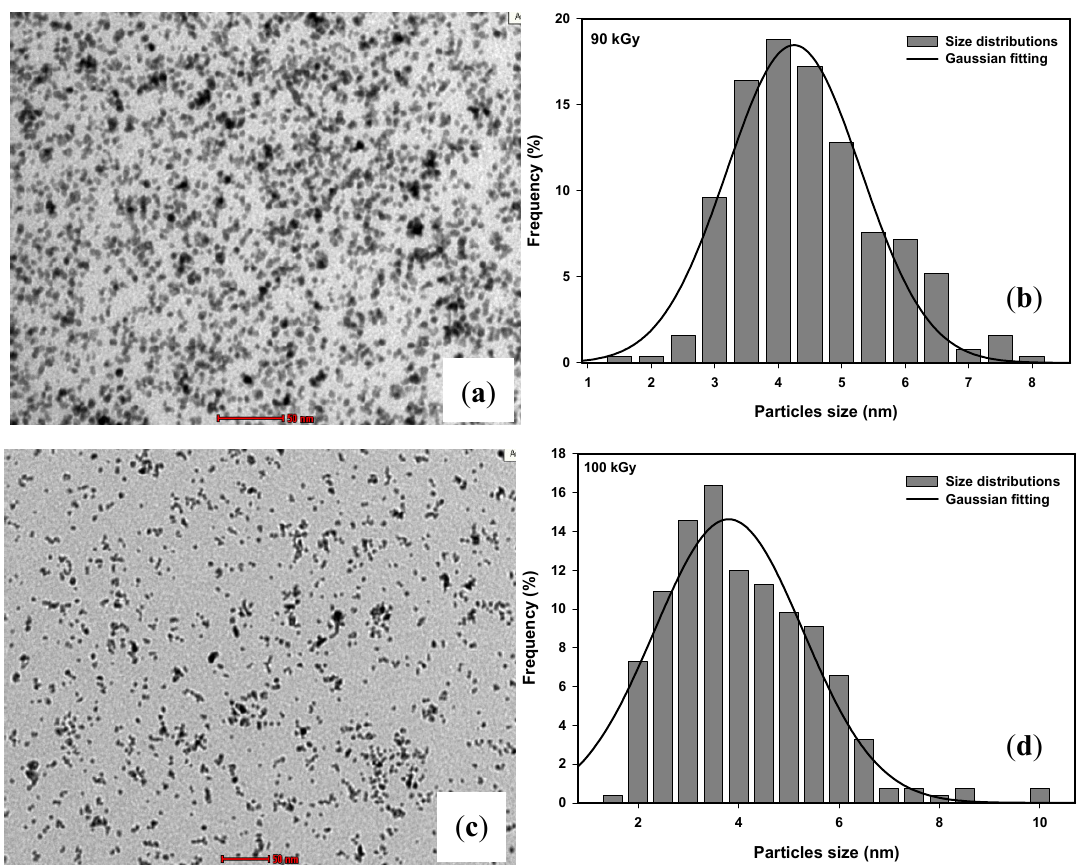
at doses of ( a ) 90 and ( c ) 100 kGy and histogram and Gaussian fitting of ( b ) 90 and ( d ) 100